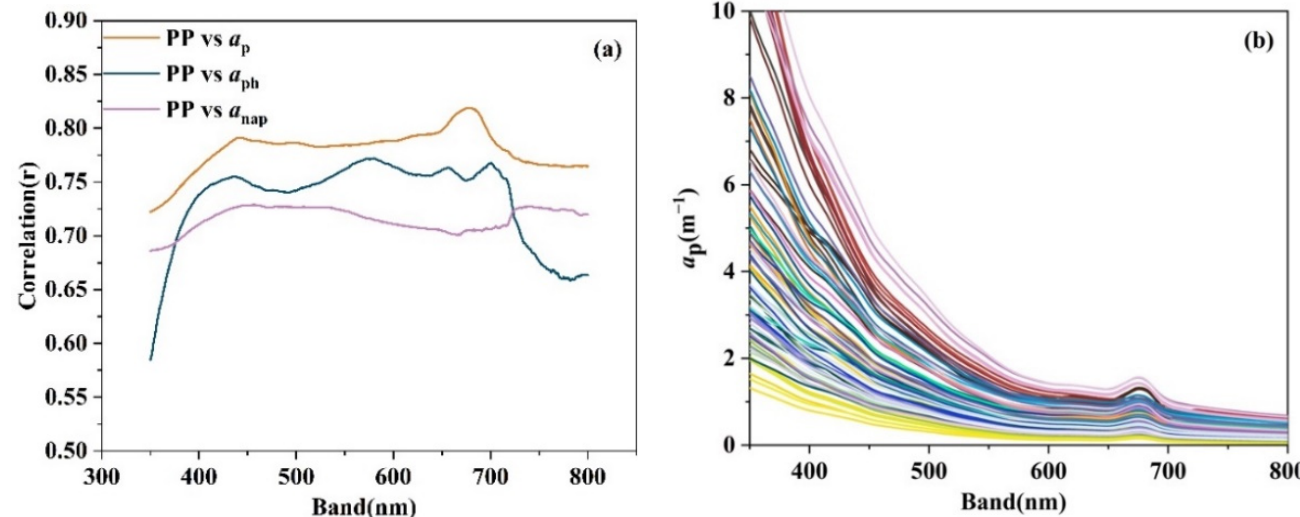
Figure 2. ( a ) The correlation between TP and a p ; ( b ) the a p absorption curve.